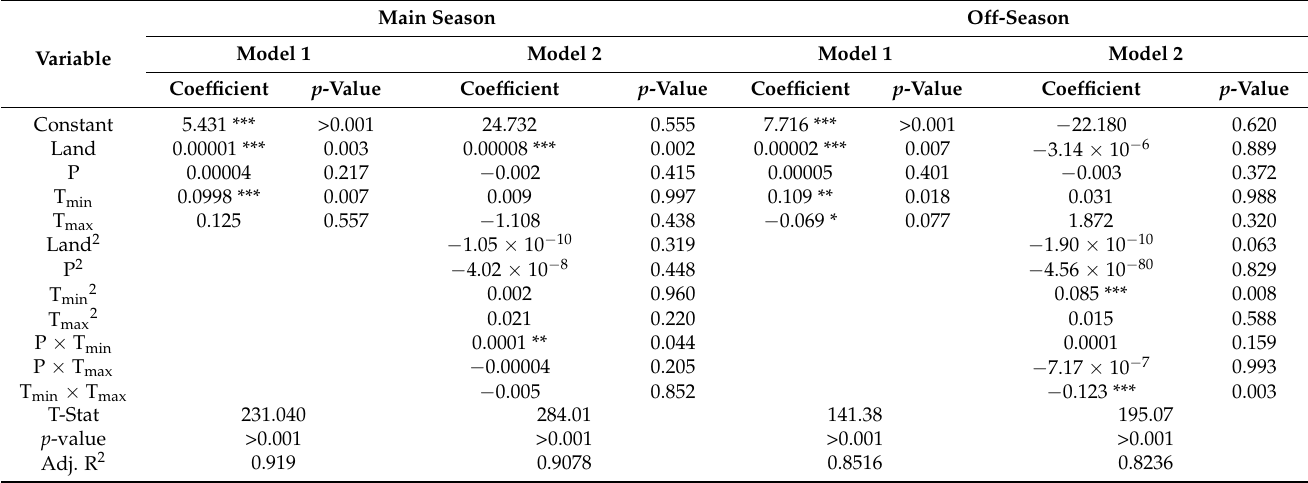
Table 7. Model estimation with PCSE for main and